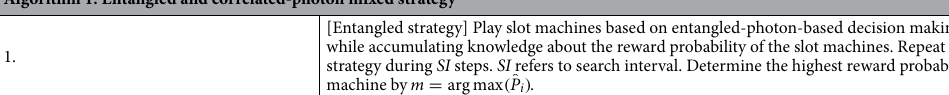
Algorithm 1: Entangled and correlated-photon mixed